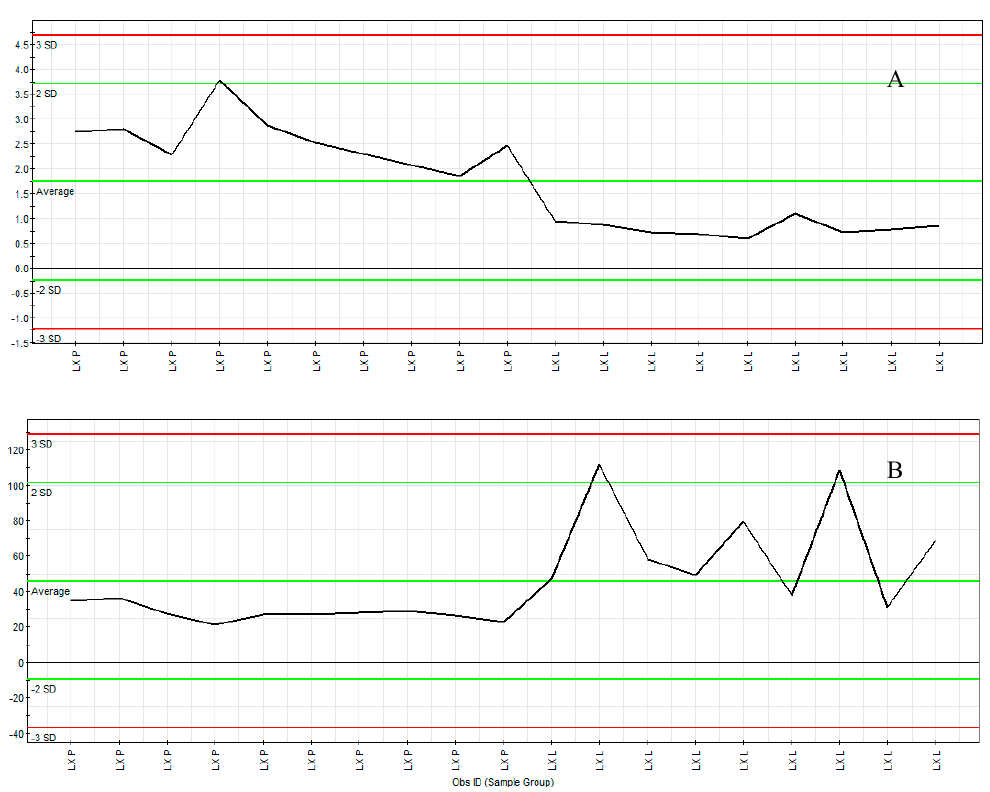
Figure 5. The ion intensity plot of LX-P and LX-L. LX-P: Natural air dried mountain cultivated ginseng; LX-L: Vacuum freeze-dried mountain cultivated ginseng; ( A ) Dendrolasin at m / z 219.1748 (t R 10.00 min); ( B ) Mal-ginsenoside Rc at m / z 1165.6094 (t R 4.85 min).